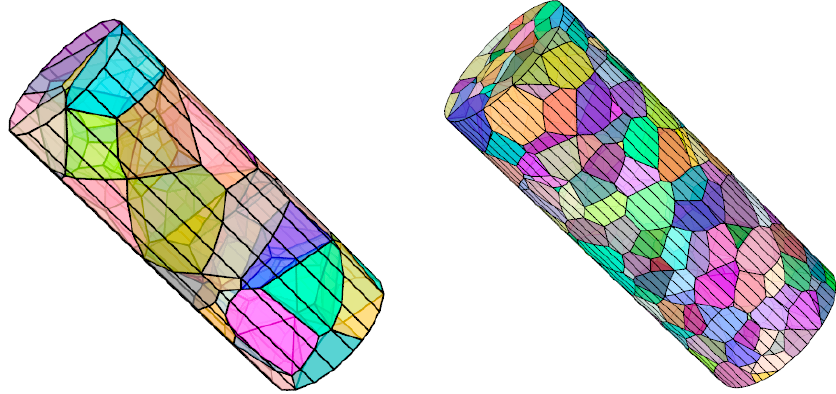
Figure 2. Polycrystalline model for the cylindrical gauge section with 49 and 500 grains.